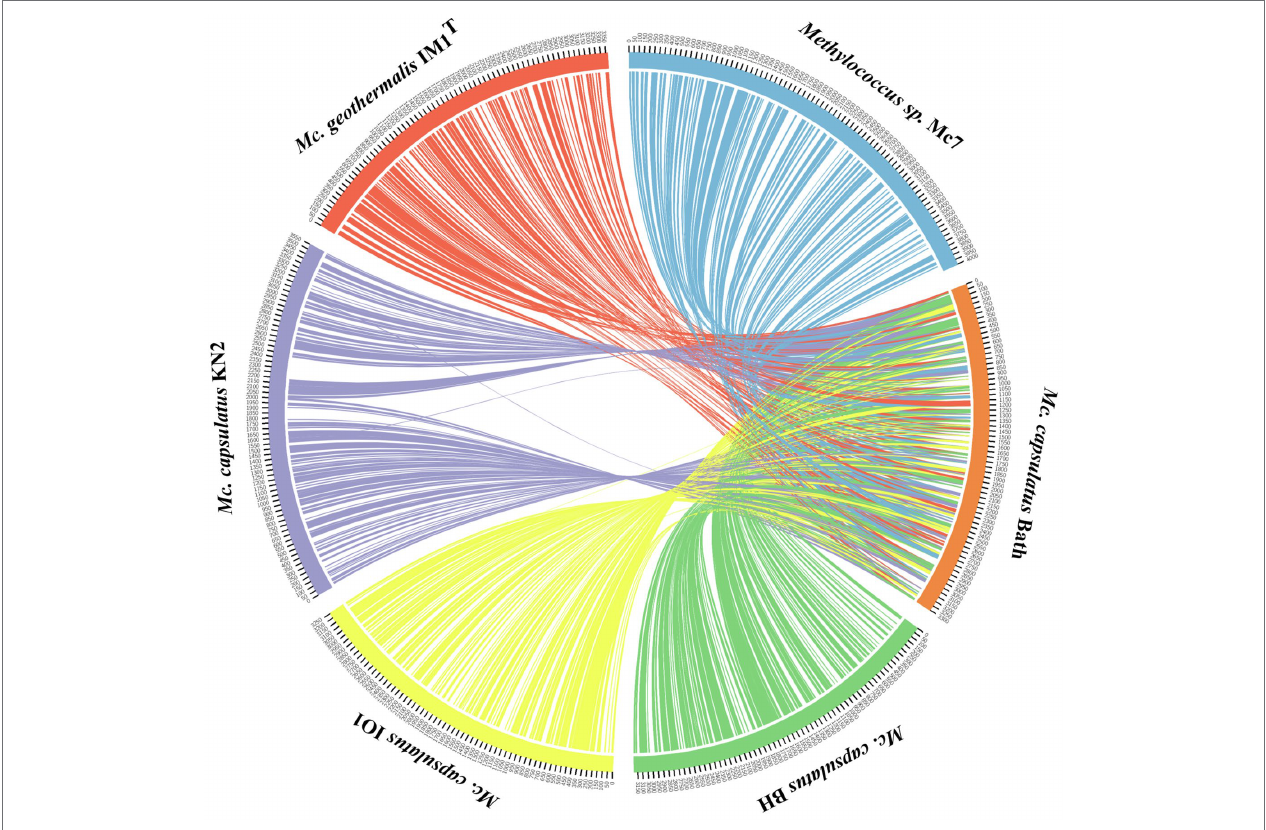
FIGURE 4 | Visualization of synteny blocks between Methylococcus capsualtus Bath and other examined Methylococcus genomes. Each link represents a single synteny block. Circle is divided into the individual arcs representing genomes of Methylococcus capsulatus Bath (orange), Methylococcus capsulatus BH (green), Methylococcus capsulatus IO1 (yellow), Methylococcus capsulatus KN2 (purple), Methylococcus geothermalis IM1 T (red), and Methylococcus sp. Mc7